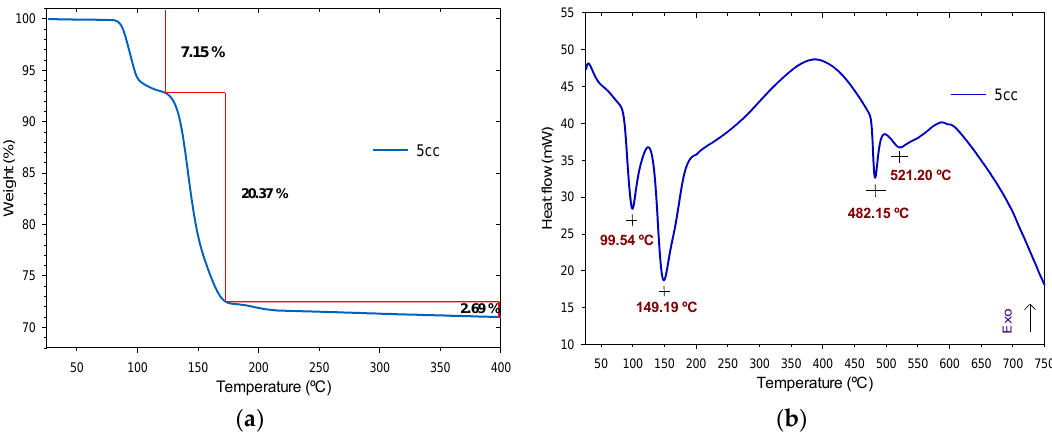
Figure 6. Cyclic carbonates results: ( a) TGA curve and ( b) DTG thermograph.